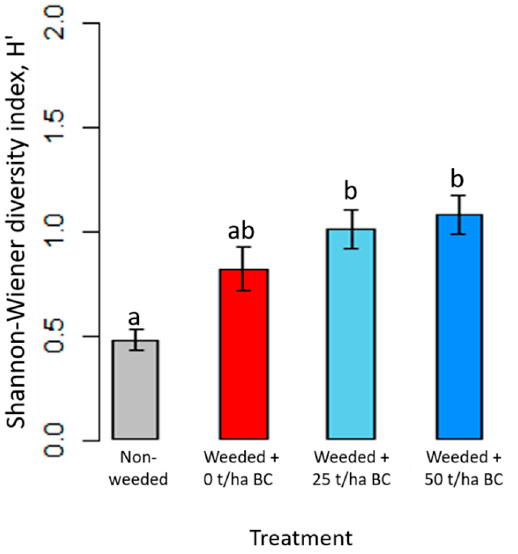
Figure 5. Shannon diversity by treatment after 30 months. Weeding (strawberry guava removal) and biochar treatments at rates of 0, 25, and 50 t/ha are compared to the non-weeded control. Means are plotted as ± 1 SE; differences significant at p < 0.05 (Scheffe post hoc tests) are indicated by different